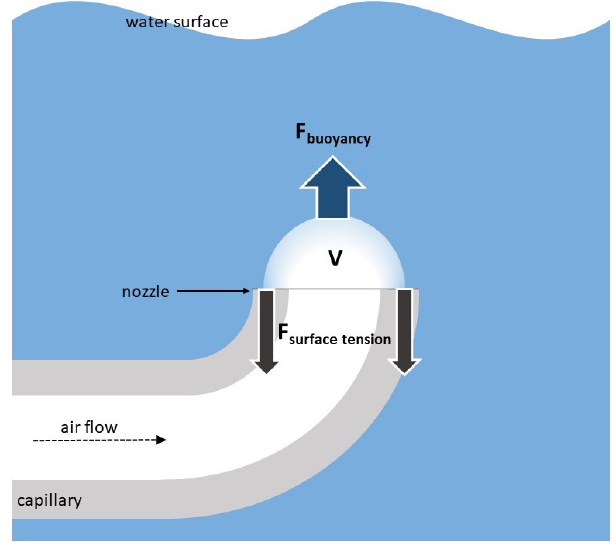
Figure 1. Schematic representation of forces affecting a bubble at the capillary nozzle surface. V is volume of the bubble, F buoyancy is Archimedean force. F surface tension is the surface tension pulling down at the rim of the